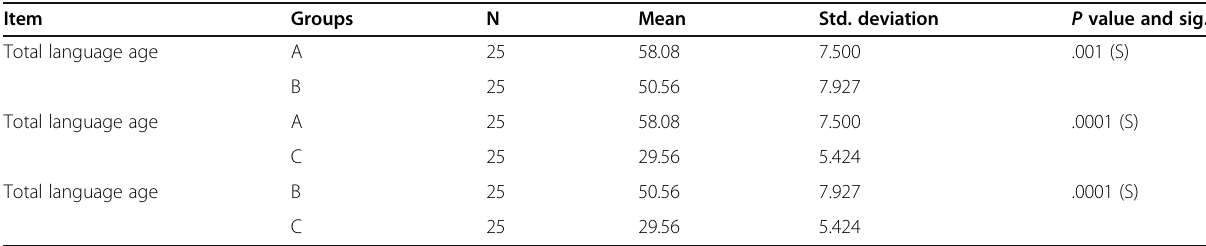
Table 1 Total language age of the study group